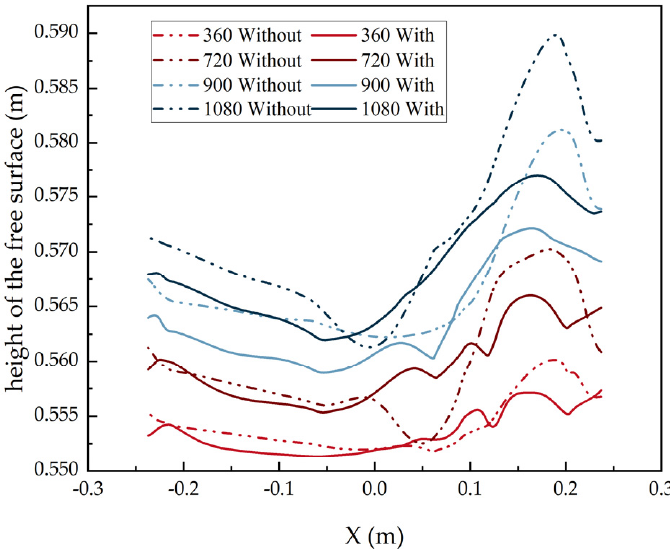
Figure 7. Free surface fluctuations at different flow rates. Figure 8 shows the local bubble size distribution at the center plane (i.e., Z = 0) of the SSF under different flow rates. From the figure, it can be seen that once a bubble enters the furnace interior (i.e., inlet diameter of 3 mm), its diameter gradually increases as it rises due to expansion. As mentioned before, at the plume’s central region, which is the dominant position to coalesce, the high chance of collision tends to increase the bubble size in the region. Figure 9 shows the distribution of number density and mean bubble diameter at four different cross-section lines. Notice that line 4 represents the intersection line at the free liquid surface (i.e., plane Z = 0). The bubble characteristics are analyzed from two perspectives in the following. As shown in Figure 9a,b, both the number density and diameter of bubbles reach the maximum value at the location of X = 0.05–0.1 m. It is because a large amount of gas enters from the inlet (i.e., X = 0.127 m) and moves vertically along the Y-direction, causing a large number of bubbles to accumulate in this region and move toward the center of the ladle. In Figure 9b, the bubble diameter has a peak at X = 0.125 m, mainly because of the spread of the bubble plume and bubble expansion. At a flow rate of 360 NL/h, the flow rate is relatively low for the gas to carry liquid to reach here. Therefore, the peak of bubble diameter here is less prominent compared to other higher flow rates. Line 3 is located at the snorkel (see in Figure 9c). The bubbles’ number density and diameter both reach the maximum value at X = 0.05–0.1 m. Similar to other locations, the peak bubble diameter increases with the increasing flow rate. Figure 9d shows bubble number density and diameter at the free liquid surface. A large number of bubbles escape at X = 0.05–0.1 m and bubble breakup occurs. In general, the average bubble diameter increases as it rises with the liquid vertically and reaches the maximum size at the free